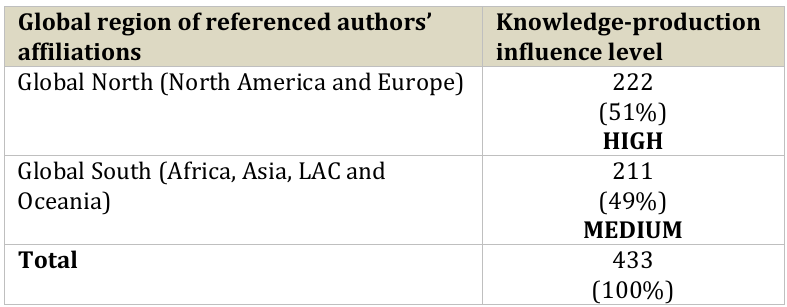
Table 6: Level of knowledge-production influence in Crimes of the powerful studies in LAC according to the referenced authors’ affiliation countries (SciELO search, 14 articles, n=433 references)